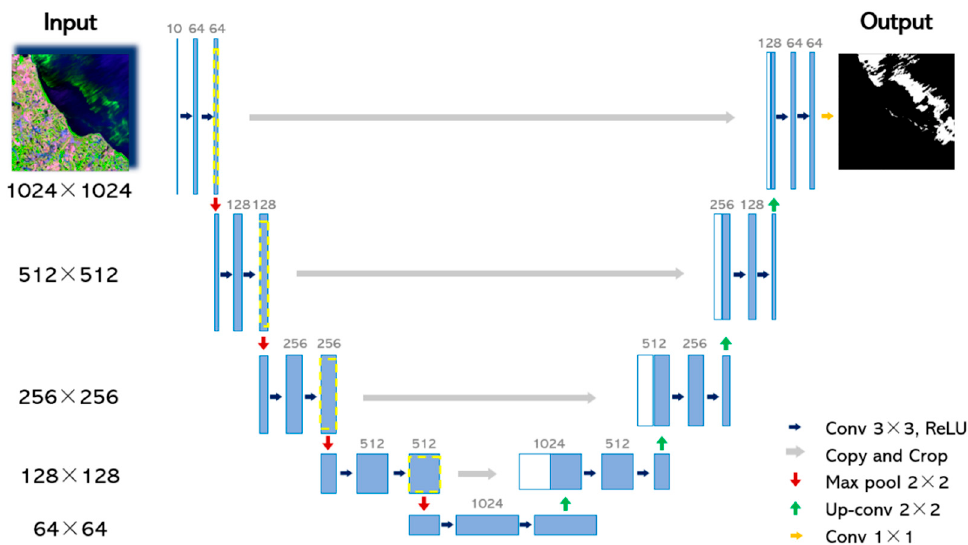
Figure 5. Structure of the U-Net network model used. Each blue rectangle represents a multi-channel feature map, and the number of channels is displayed at the top of the rectangle. The white rectangle represents the copied feature maps (represented by yellow dashed lines and gray arrows). The feature map size in each of the five rows is marked in the first column (e.g., 1024 × 1024).